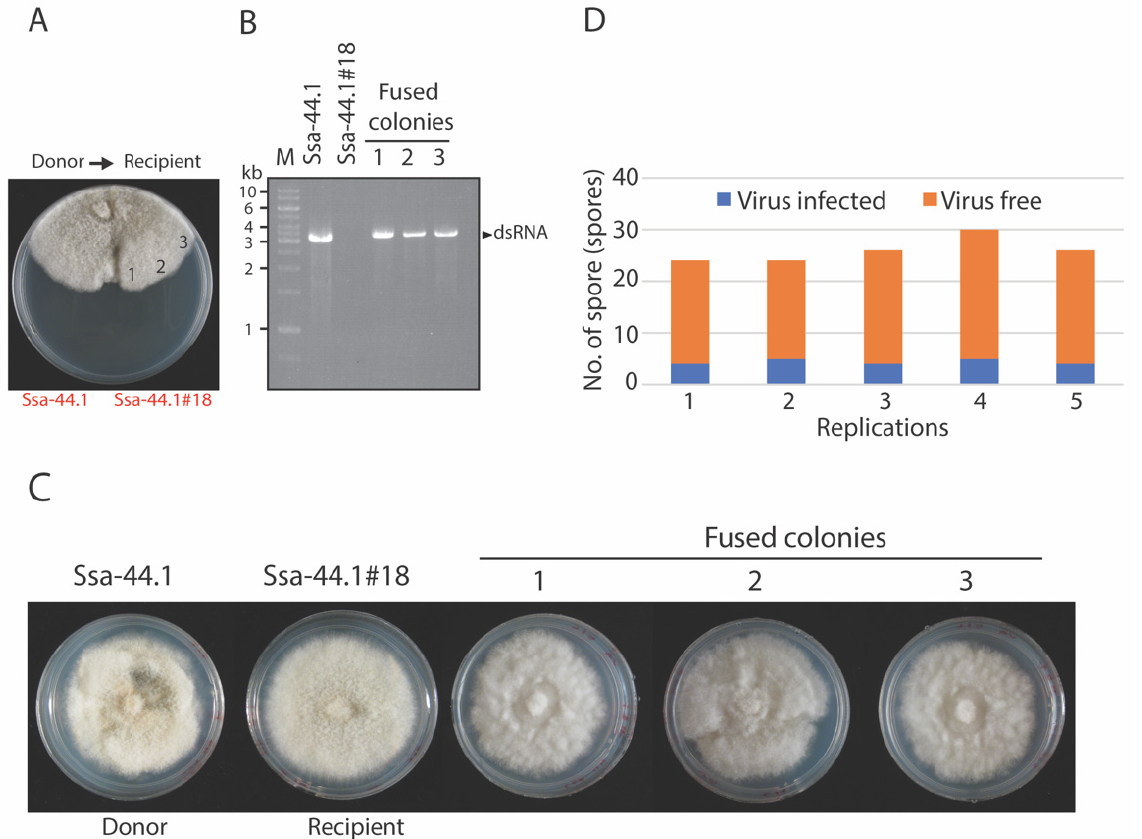
Figure 4. Transmission of CgRV1-Ssa-44.1 to C. gloeosporioides. ( A ) Horizontal transmission via co-